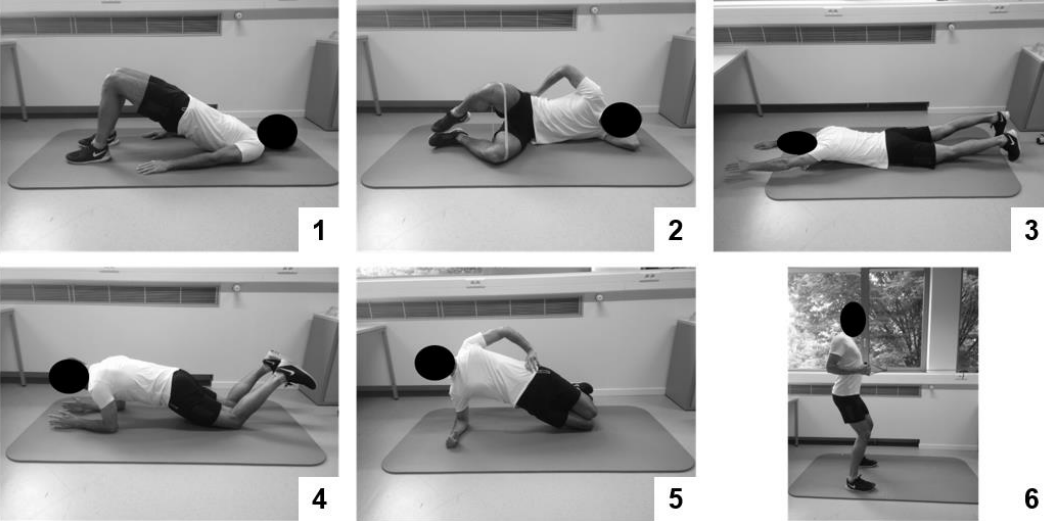
Figure 3. Baseline strength exercises in the core strength protocol: ( 1 ) glute bridge, ( 2 ) glute clam, ( 3 ) lying diagonal back extension, ( 4 ) adapted knee plank, ( 5 ) adapted knee side plank, and ( 6 ) shoulder retraction with hip hinge.